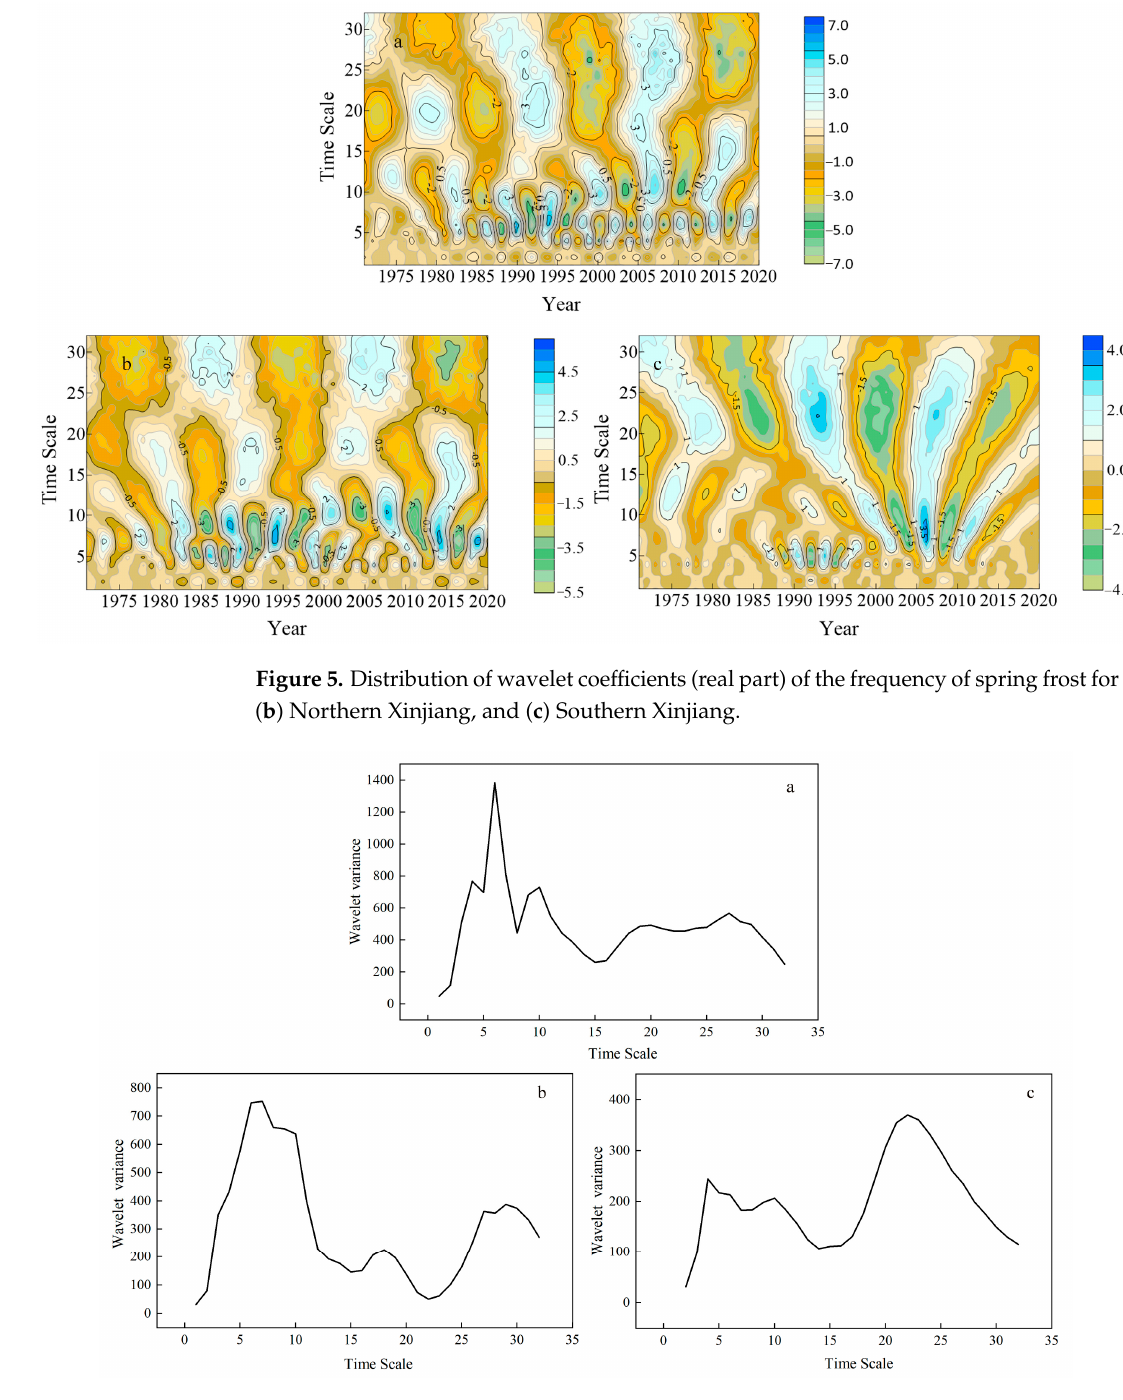
Figure 6. Distribution of wavelet coefficient (variance) of the total number of spring frost events in Xinjiang in the past 50 years: ( a ) Xinjiang, ( b ) Northern Xinjiang, and ( c ) Southern Xinjiang.